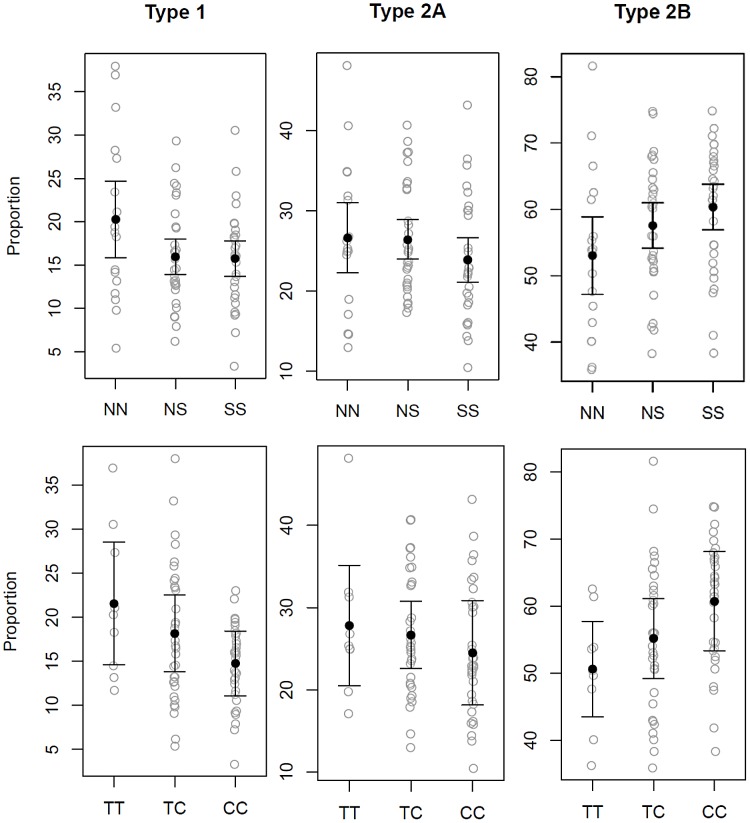
Gluteal fiber type proportions observed based upon MSTN SINE and intron 1 SNP genotype.Gluteal muscle fiber type proportions in 79 Quarter Horses based upon myostatin genotypes, not accounting for age and sex. The top panel shows the SINE (N = wild-type allele, S = SINE insertion) and bottom panel the intron 1 SNP genotypes. Each grey circle indicates fiber type proportion in one horse (y-axis). The mean is shown with a black dot and the error bars represent 95% confidence intervals around the mean. The SINE and SNP are each significantly associated with a lower proportion of Type 1 and higher proportion of Type 2B muscle fibers.